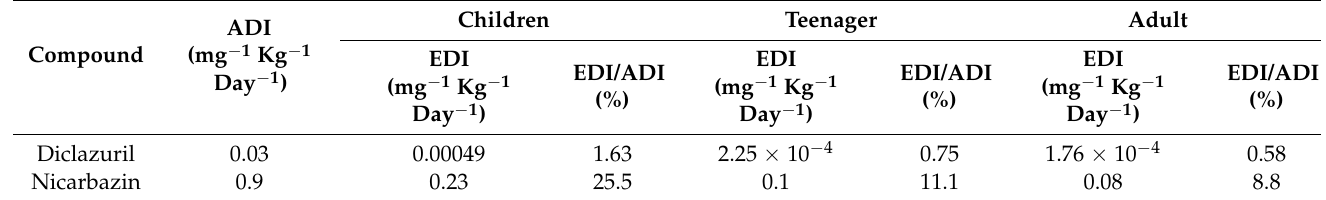
Table 5. Comparison of ADI and EDI (mg kg − 1 day − 1 ), using the average detected concentrations for the children, teenagers, and adult